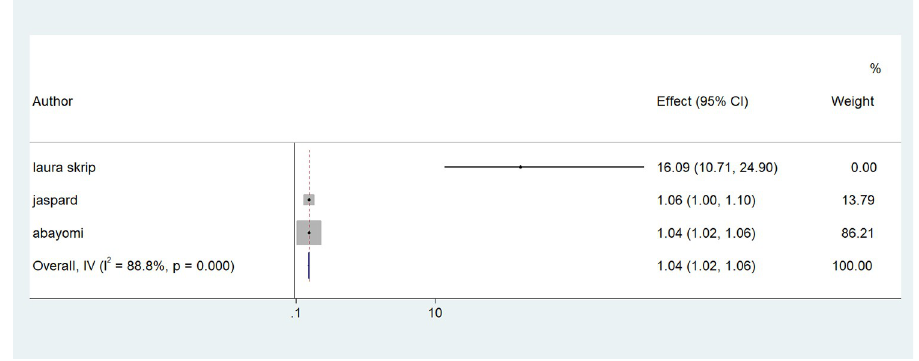
Fig 11. Forest plot showing the estimate for the effects of high median or mean or no on COVID-19